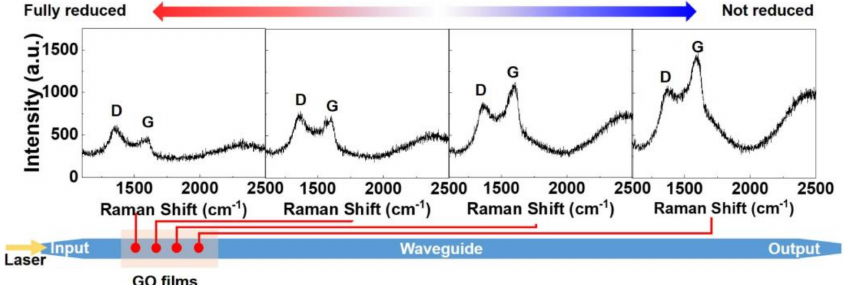
Figure 5. Raman spectra of 2 layers of GO coated on an integrated waveguide after applying an input CW power of 24